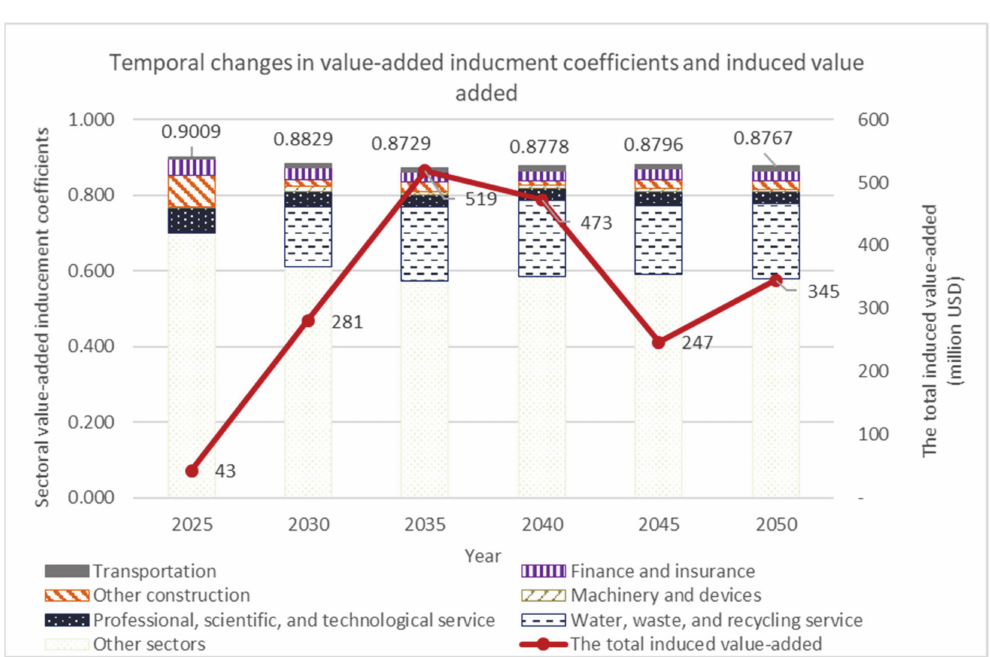
Figure 5. The total and sectoral value-added inducement coe ffi cients of nuclear decommissioning. (Note: This figure presents the sectoral output inducement coe ffi cients of some industries that have larger e ff ects. The e ff ect on industries beyond these six sectors is combined into “Other sectors.”).